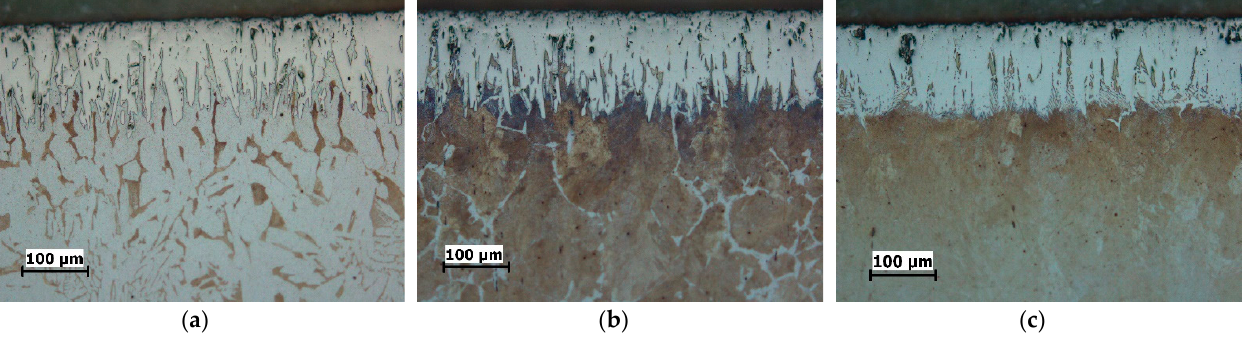
Figure 4. Microstructure of the boride layers obtained by boronizing at 970 °C for 4 h, magnification 200:1: ( a ) C15 steel; ( b ) C45 steel; ( c ) C70W2 steel.